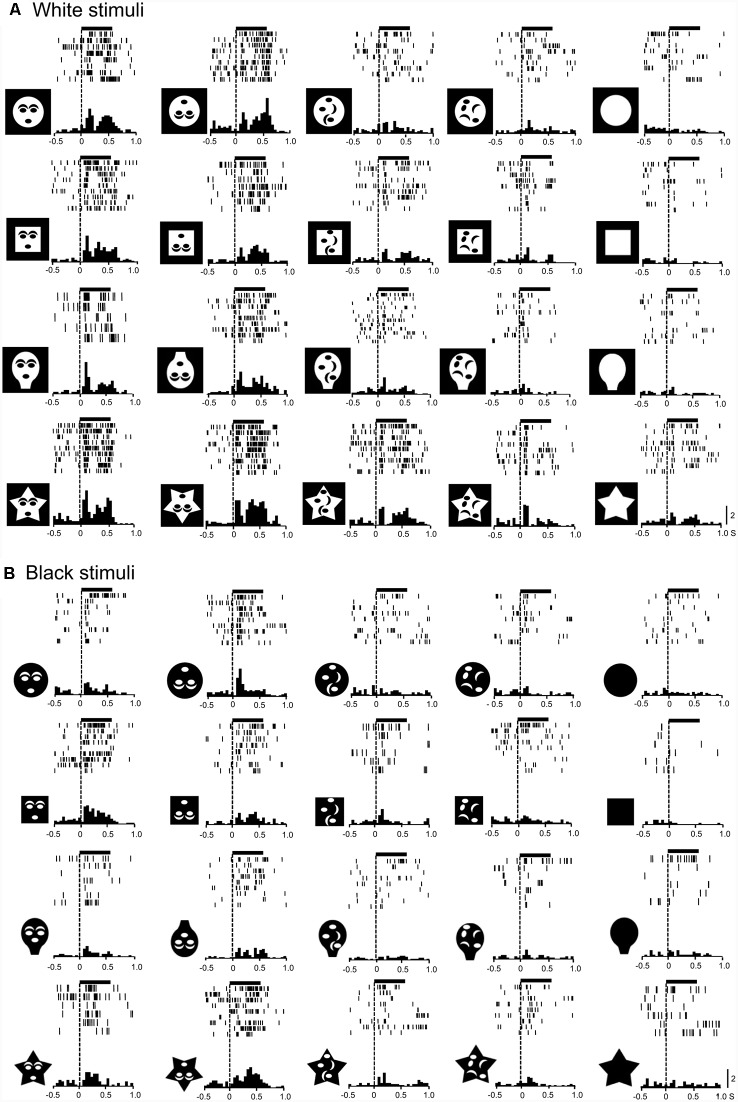
Visual responses of an superior colliculus (SC) neuron to the white (A) and black (B) stimulus sets. Horizontal bars above the raster displays indicate the stimulus presentation period (500 ms). The vertical dotted line in each of the raster displays and histograms indicate the stimulus-onset point. Calibration at the right bottom of the figure: number of spikes per trial in each bin. Bin width, 50 ms. Zero on the abscissa indicates the onset of the stimuli.